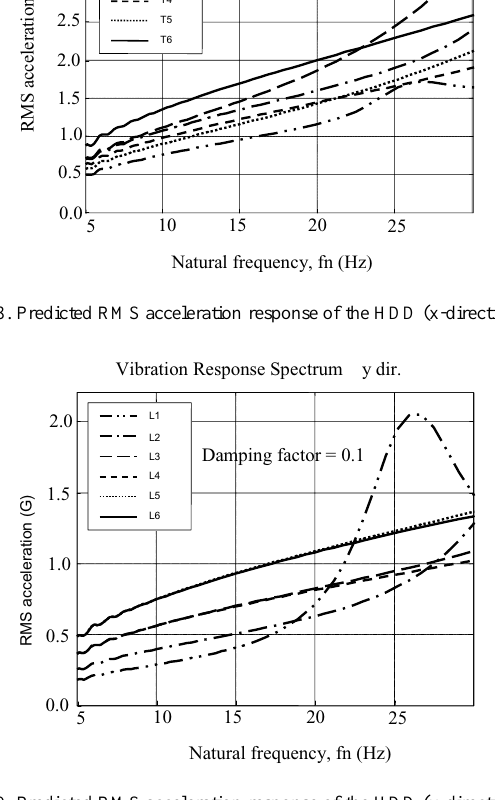
Fig. 9. Predicted RMS acceleration response of the HDD